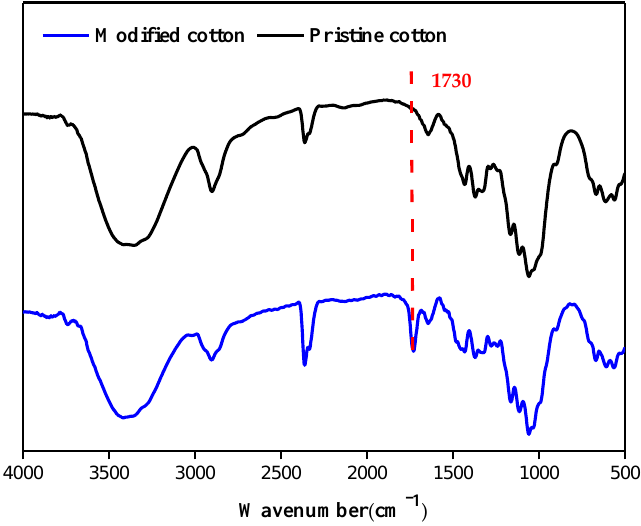
Figure 4. FT-IR spectra of the cotton before and after modification.